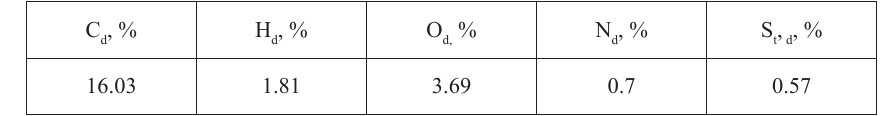
Table 1. Characteristics of raw oil shale sample,